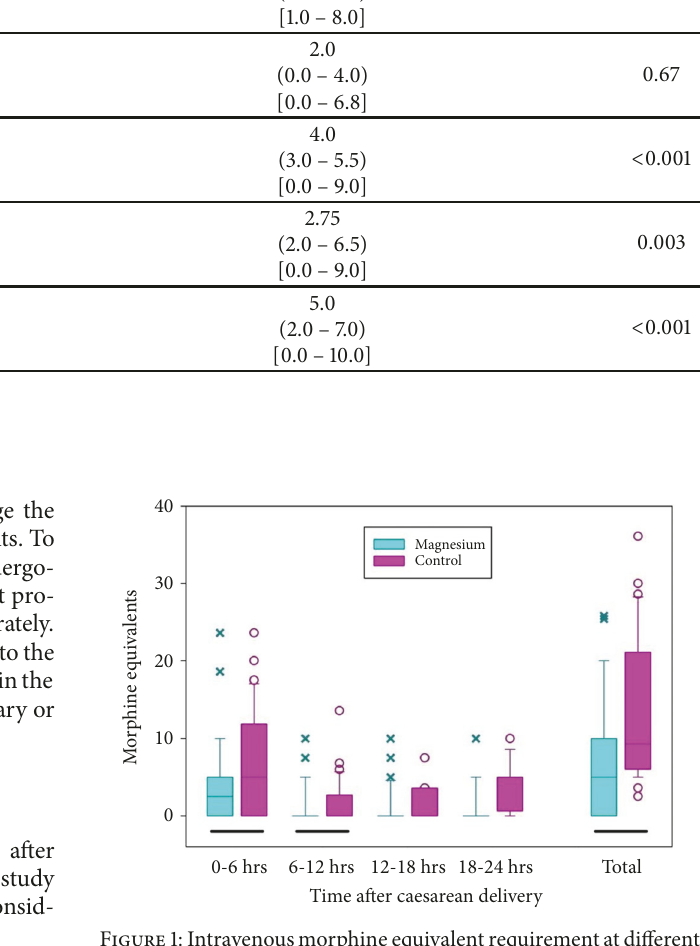
Figure 1: Intravenousmorphine equivalent requirementat different time intervals.Statistically significant at0–6 hand 18–24 h,as well as for total requirement. Box shows the interquartile range, horizontal line within box shows median, whiskers show 10/90th percentiles, x and o show points outside of the 10/90th percentiles. Solid bar beneath pairs of groups indicates a significant difference between the groups (p <